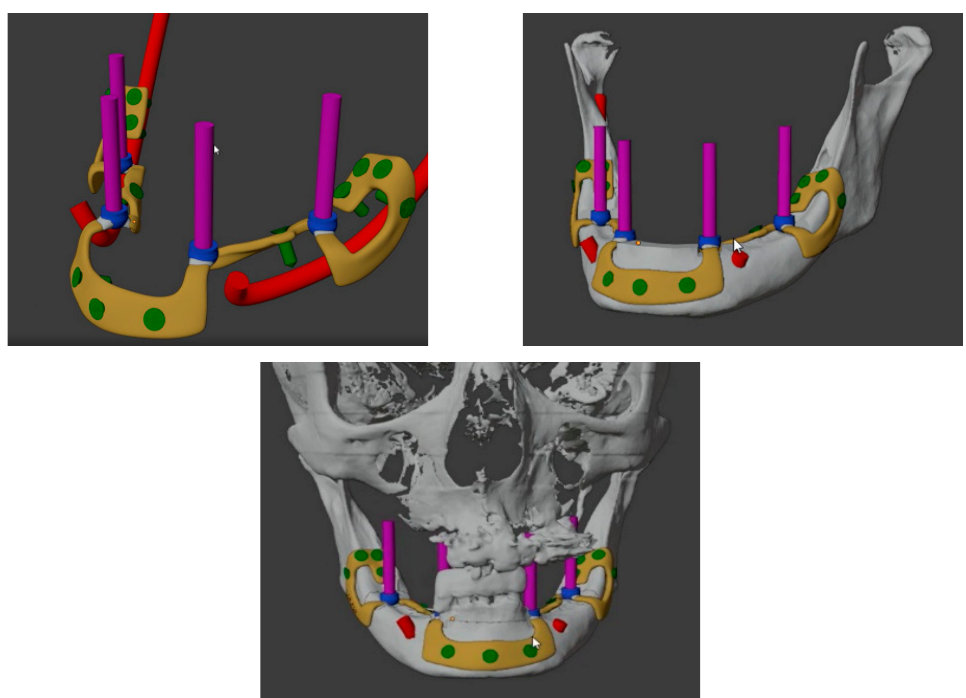
Figure 2. Three-dimensional reconstructions of the design of the subperiosteal implant for the upper jaw made by three-dimensional medical SABETTIMED ® .